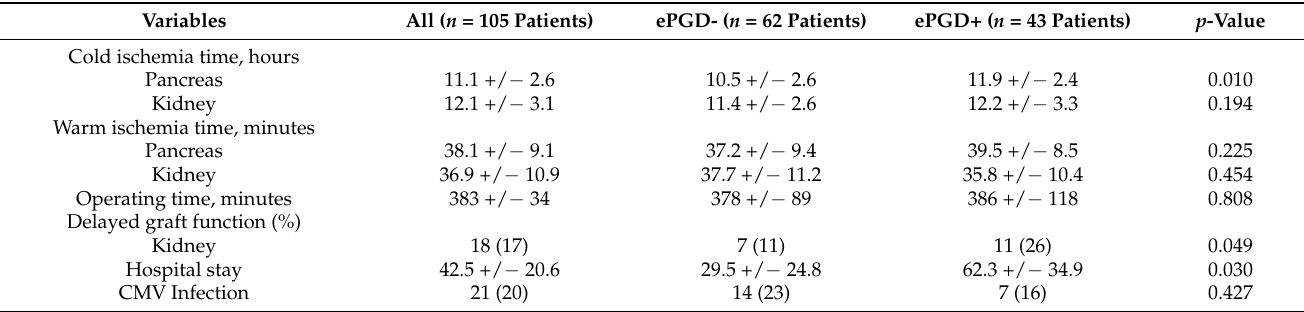
Table 2. Intra- and postoperative outcome and function associated with early pancreatic graft dysfunction (ePGD) following simultaneous pancreas–kidney transplantation.